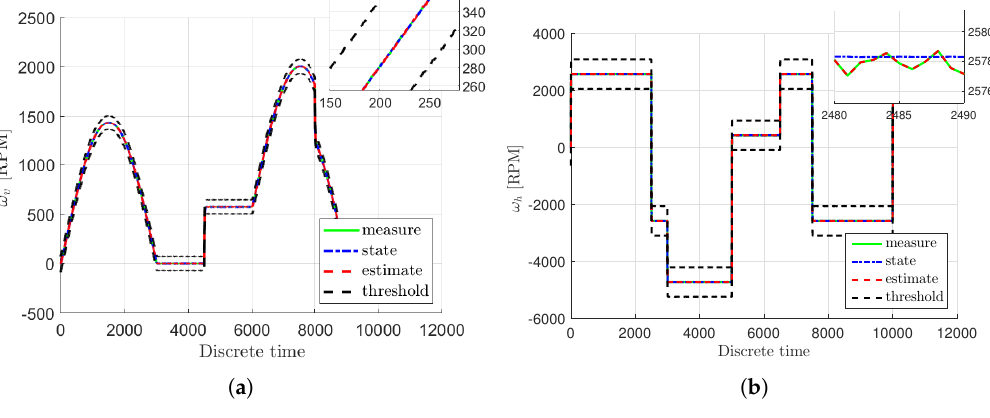
Figure 5. State variables ω v ( a ) and ω h ( b ).